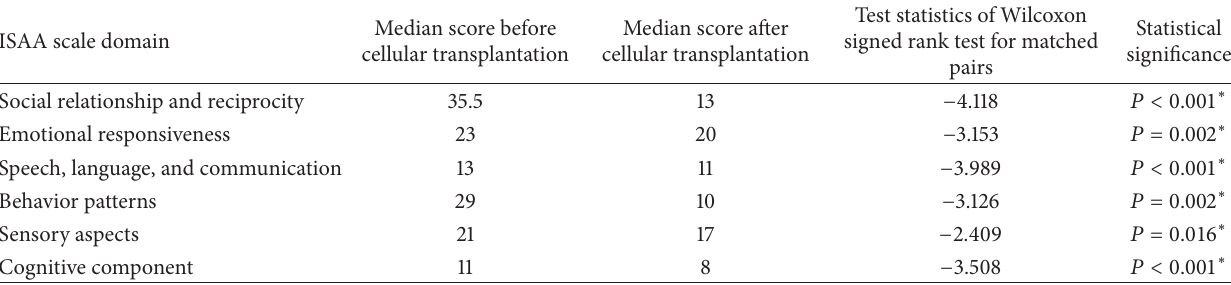
Table 3: Change in the ISAA scores of individual domains measured before and after intervention.